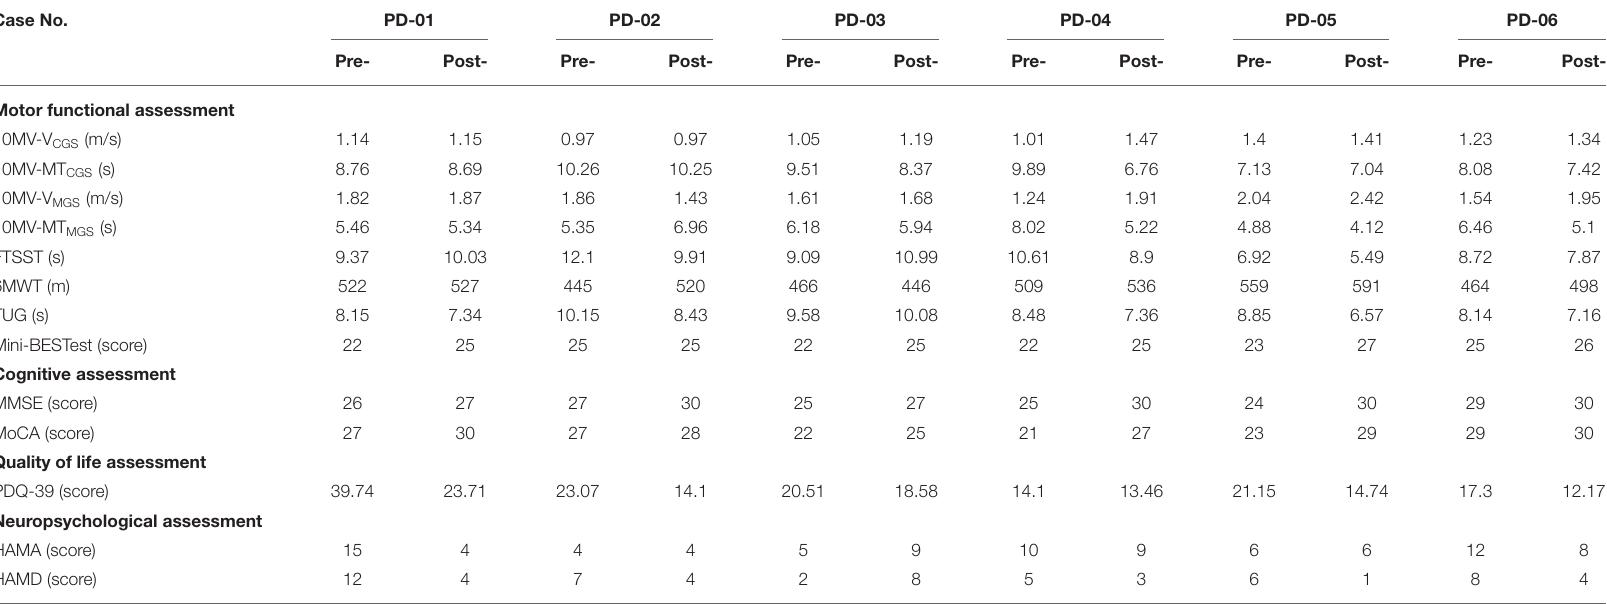
TABLE 4 | The results of motor, cognitive, quality of life, and neuropsychological assessment in the pre- and post-rehabilitation PWPs. Case No. PD-01 PD-02 PD-03 PD-04 PD-05 PD-06 Pre- Post- Pre- Post- Pre- Post- Pre- Post- Pre- Post- Pre- Post-